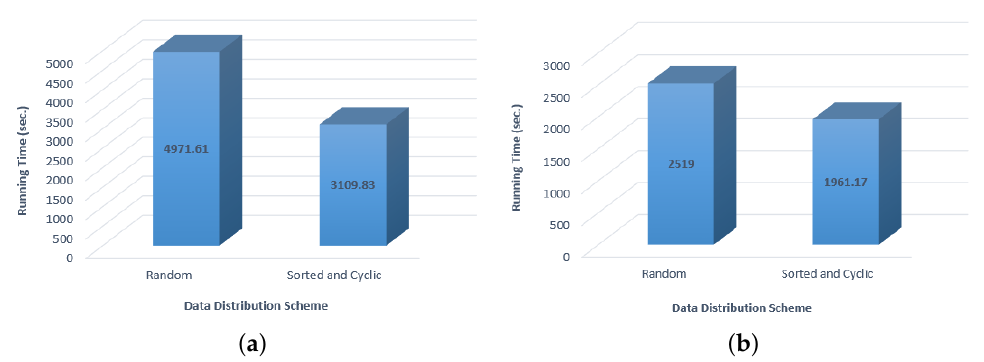
Figure 14. Comparison of load balancing techniques using ( a ) GeoLife dataset ( b ) Genome dataset.